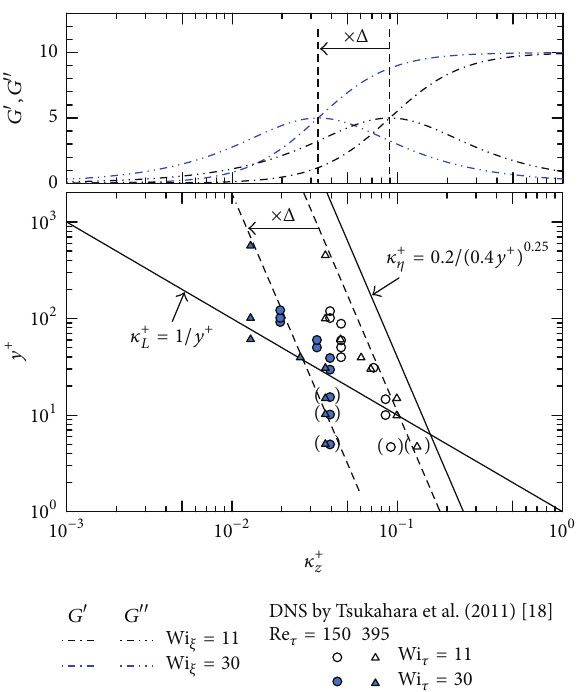
Figure 4: (a) Dependence of the storage modulus and loss modulus on a frequency for the viscoelastic fluid of Giesekus model. (b) Scal- ing relation in the turbulent channel flow with/without drag reduc- tion: shifting in the wave number of the energy-dissipative range by viscoelastic